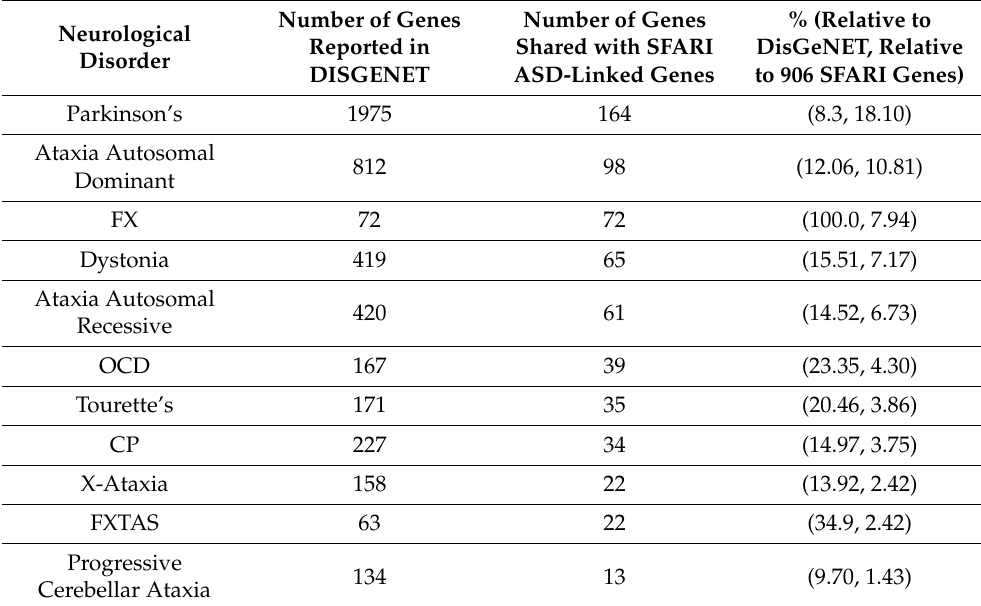
Table 2. Overlap between Autism-linked genes in SFARI and known neurological disorders of genetic origins ranked based on % relative to the set of 906 SFARI genes under consideration here.